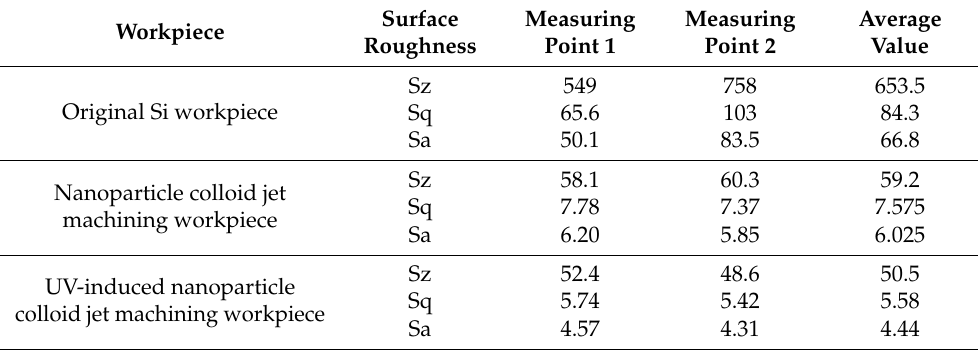
Table 4. Surface roughness of the three Si workpieces (all values are in